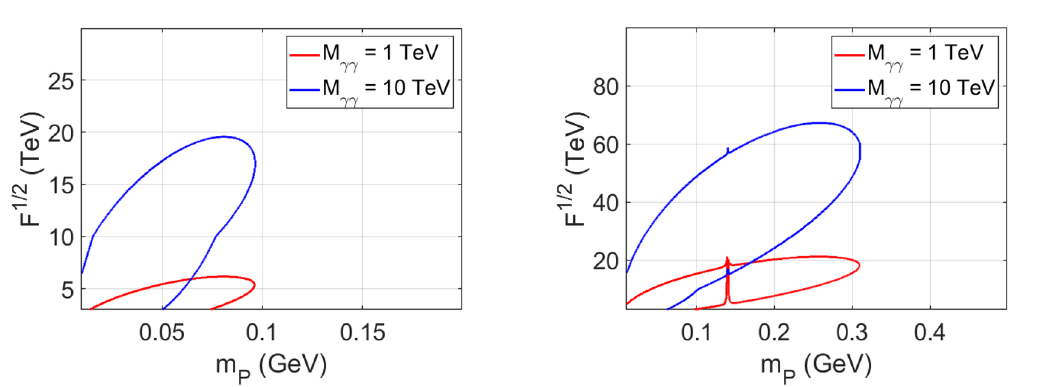
Figure 25 . Sensitivity region of FASER-I (left plot) and FASER-II (right plot) to models with sgoldstino. Pseudoscalar sgoldstinos are produced in Primakoff process and decay into a pair of photons. M 3 = 3 TeV. In the regions where